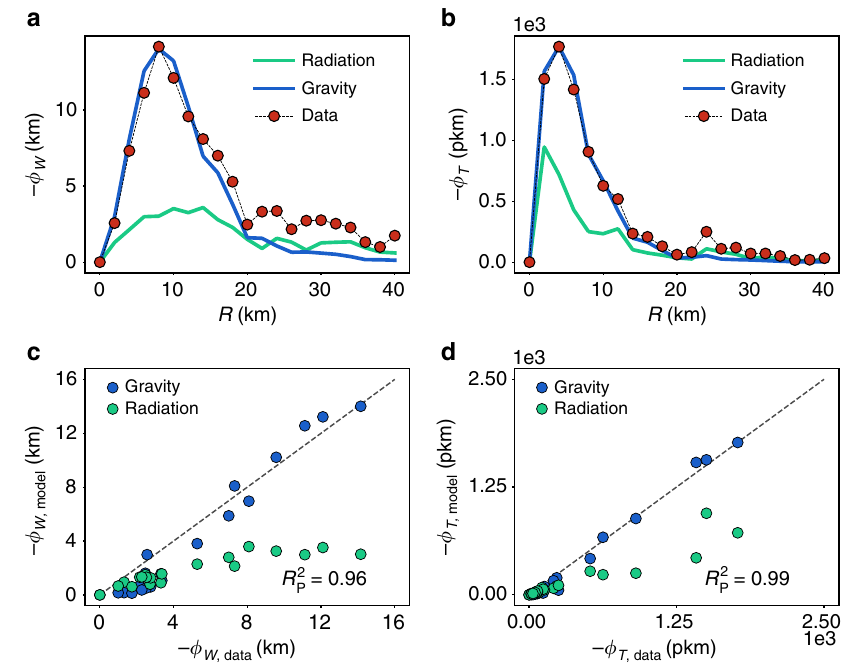
Fig. 4 Model comparison. Red dots represent the fl uxes measured with the empirical vector fi eld. In the blue solid line, we show the predicted fl uxes with the gravity model with an exponential deterrence function while the green curve corresponds to the radiation results. Results for London of a Φ W with a ¼ 0 : 96 and b for the fl ux of T with R 2 ¼ 0 : 99. In both cases, d = 9.4 km. c , d are correlation comparison between the gravity model and the data of R 2 0 P P plots between the gravity and the empirical fl ux. The results for the radiation are systematically below the diagonal. The units for Φ W are in kilometers (km), while those of Φ T are in persons multiplied by kilometer